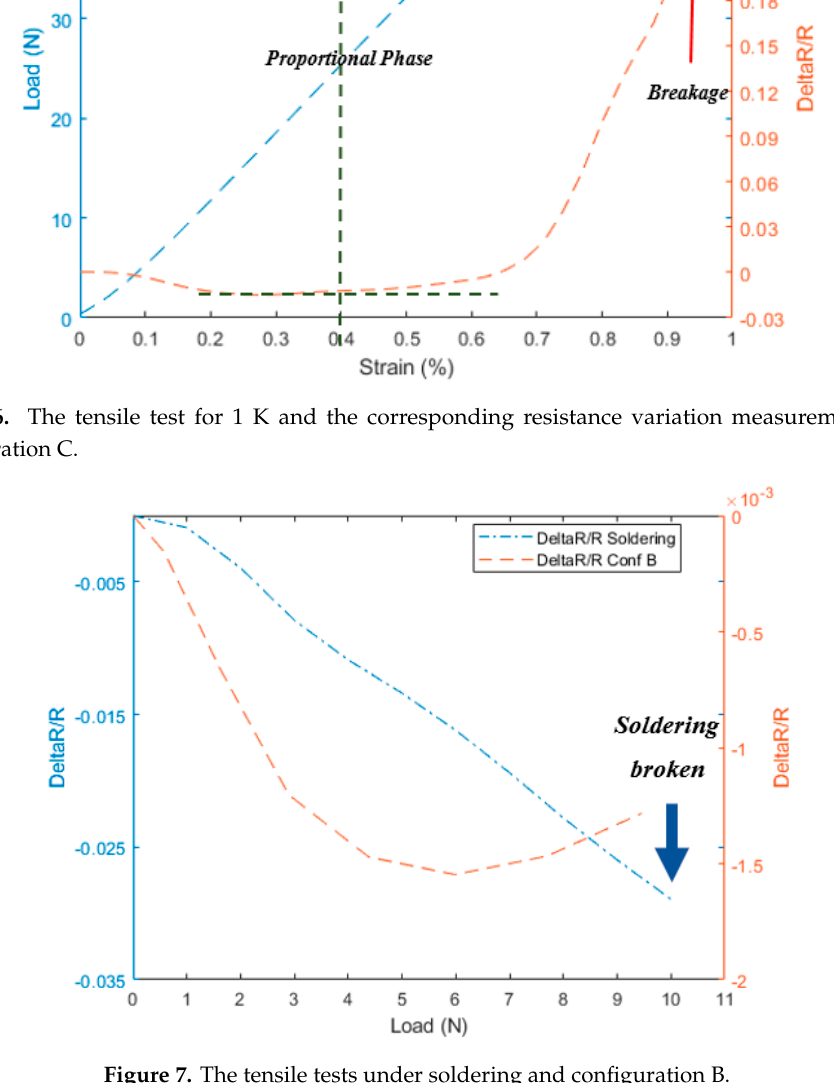
Figure 7. The tensile tests under soldering and configuration B.